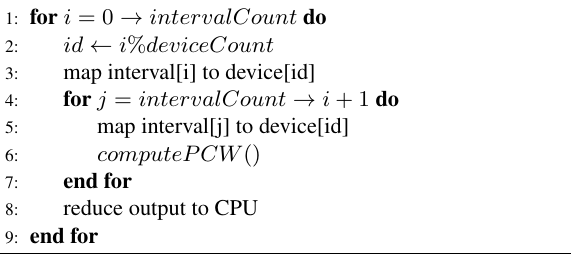
Algorithm 3 : High Level View of Map Reduce for Multi-GPU